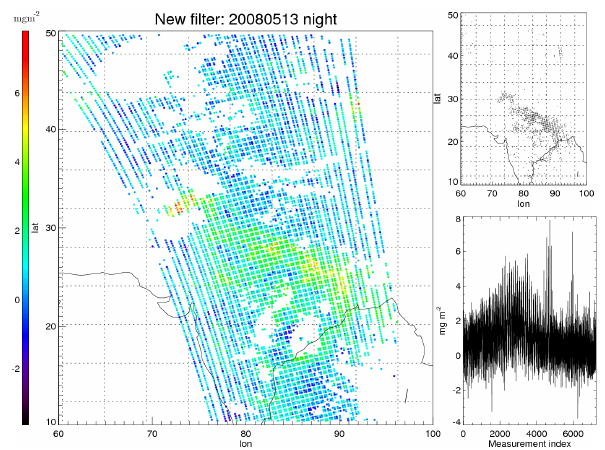
Fig. 14. As in Fig. 13 but using the new ammonia